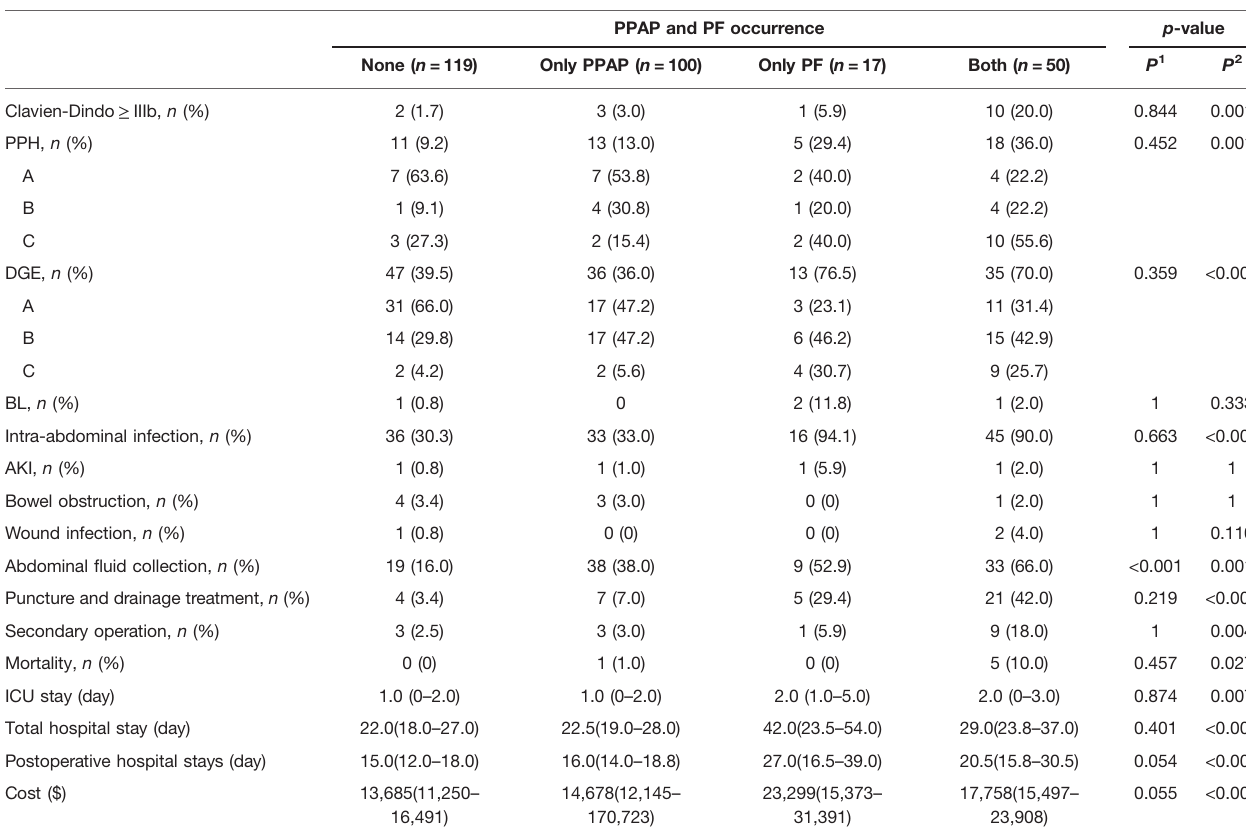
TABLE 7 | Postoperative complications grouped by PPAP and PF